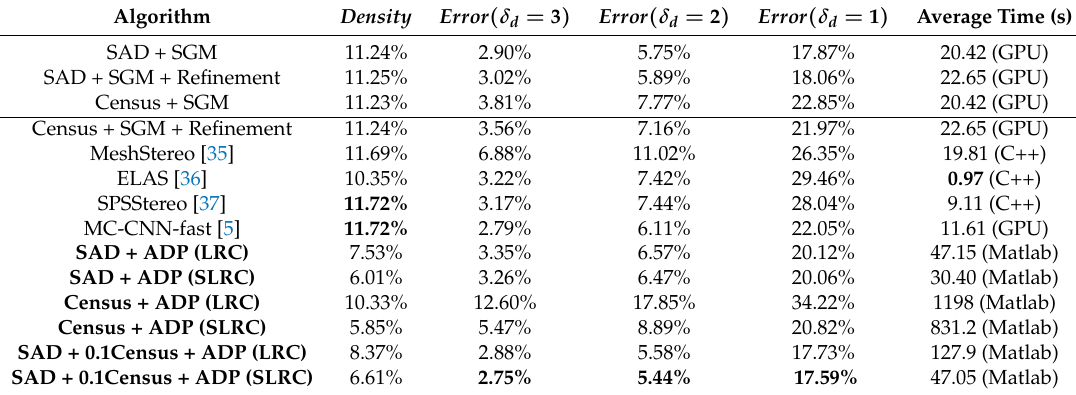
Table 2. Comparison between our method and other methods.